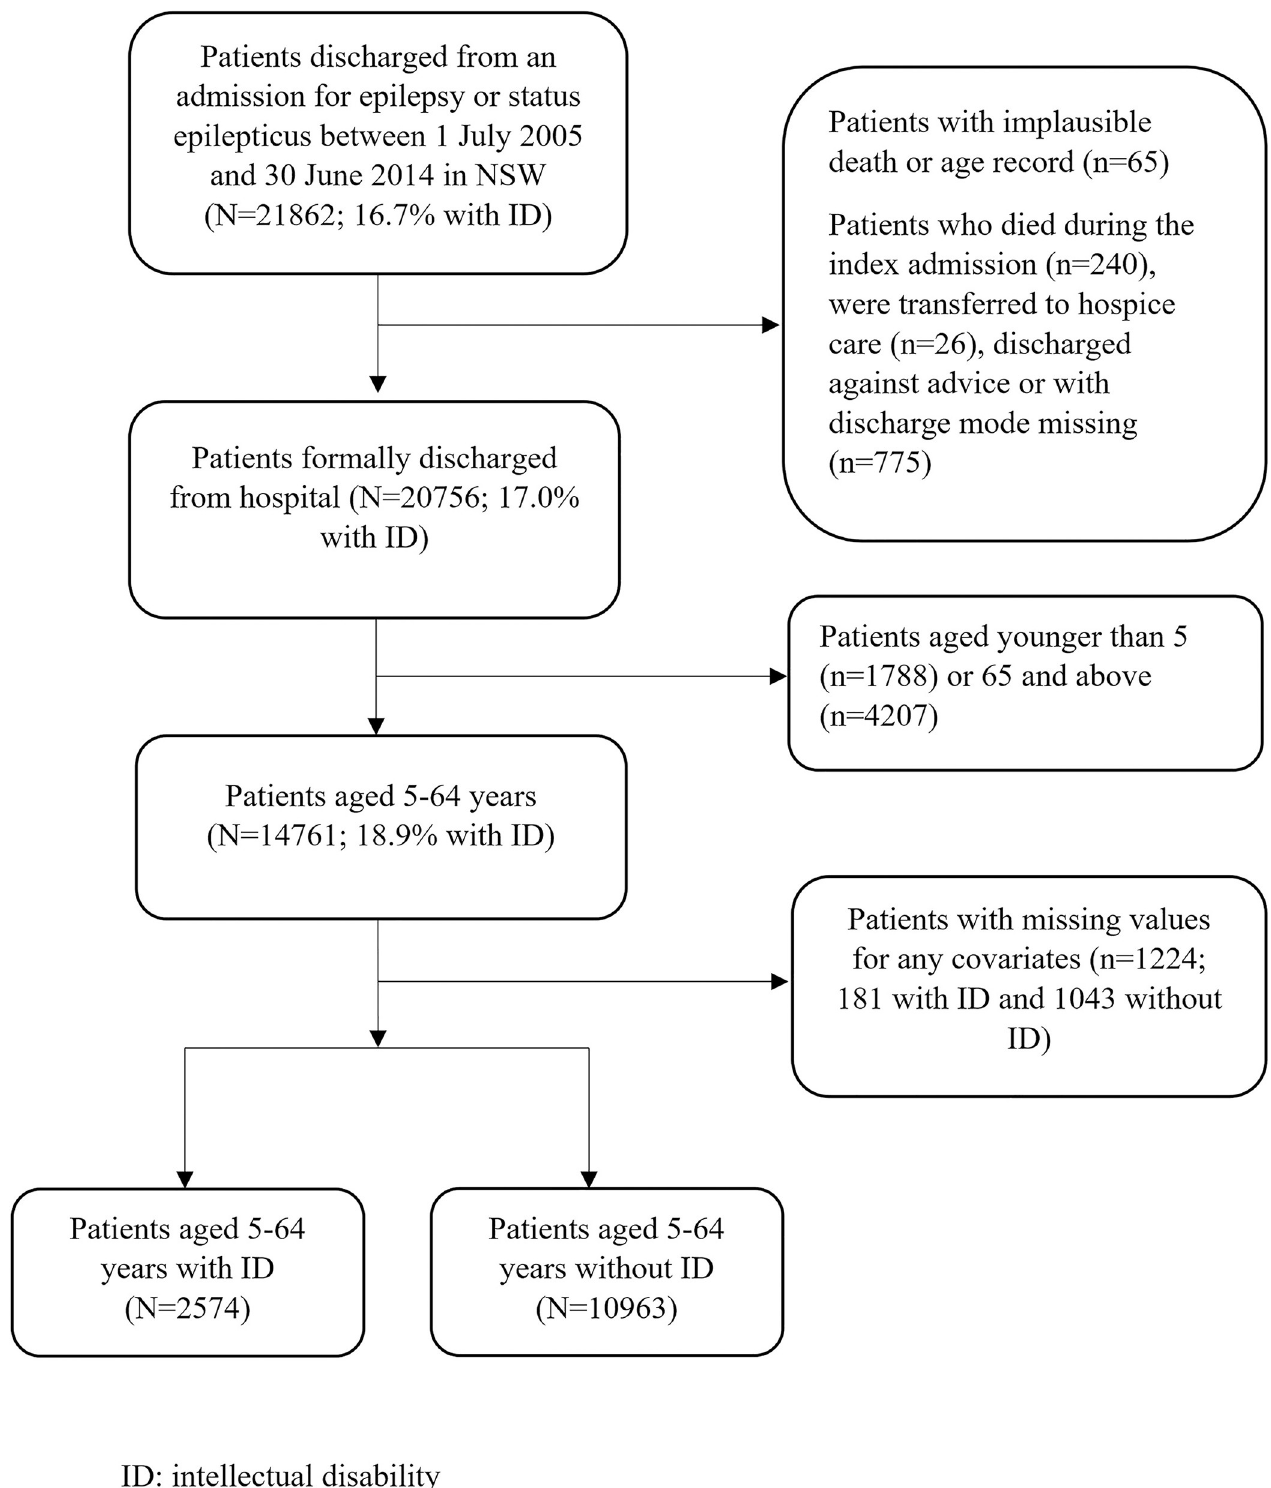
Fig 1. Cohort derivation